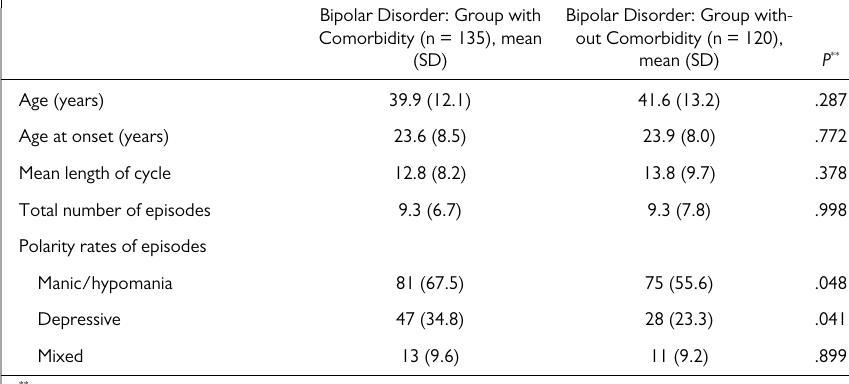
Table 2. Sociodemographic and Clinical Characteristics of Bipolar Patients with and without a Comorbid Disorder